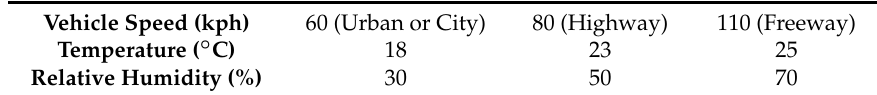
Table 1. The inlet conditions of vehicle velocities, temperatures and relative humidity in computational fluid dynamics (CFD) simulation.